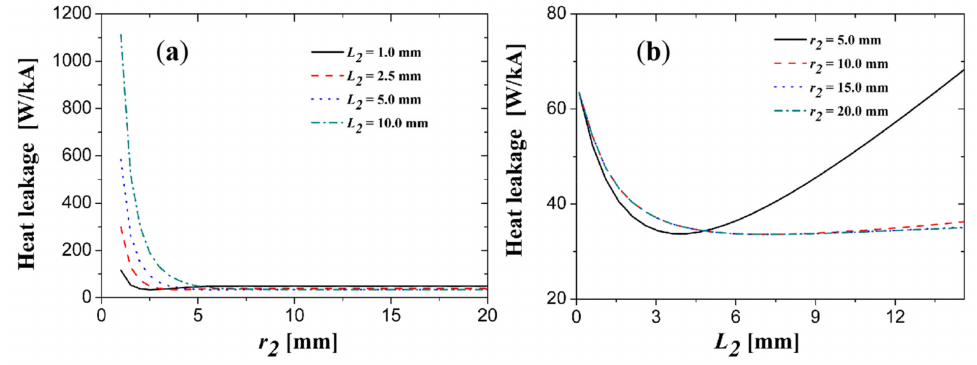
Figure A4. Iteration step 1: the coupling influence between D ( r 2 ) and E ( L 2 ) on the cold end heat leakage of PCLs (keeping parameters r 1 = 5.0 mm, L 1 = 10.0 mm, L 3 = 1500.0 mm unchanged; in this iteration Q min = 33.6 W/kA). ( a ) The heat leakage vary with D ( r 2 ); ( b )The heat leakage vary with E ( L 2